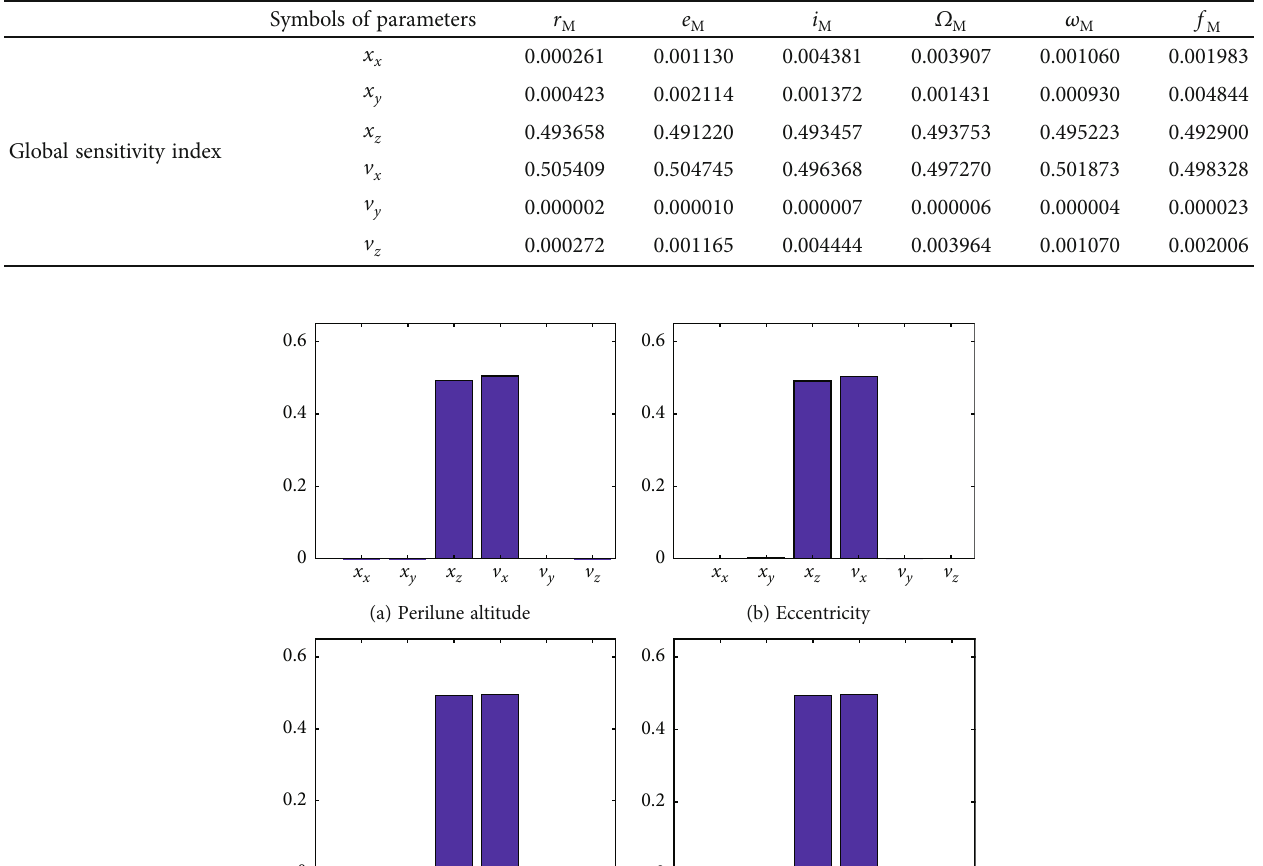
Table 8: Sensitivity index for position and velocity parameters.